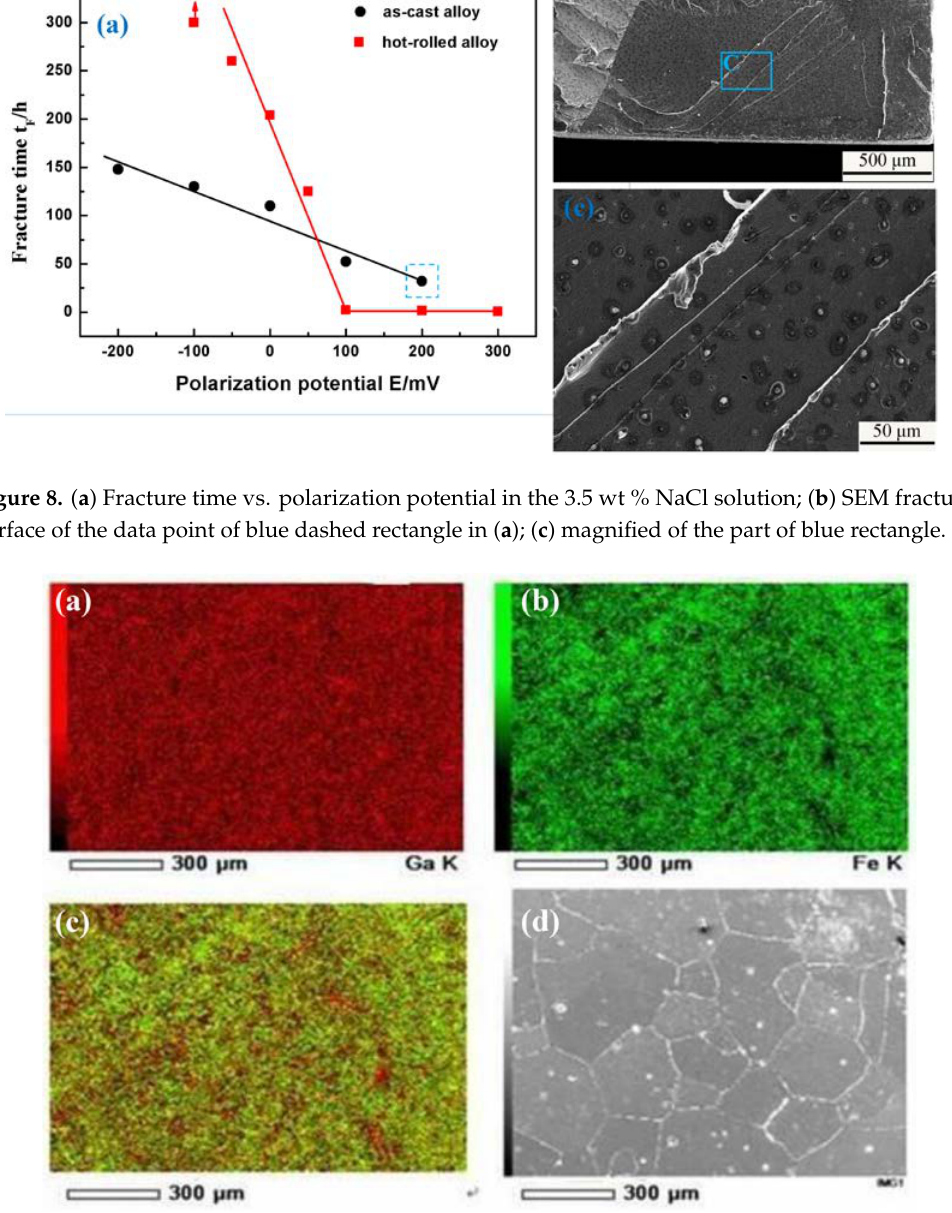
Figure 8. ( a ) Fracture time vs. polarization potential in the 3.5 wt % NaCl solution; ( b ) SEM fracture surface of the data point of blue dashed rectangle in ( a ); ( c ) magnified of the part of blue rectangle.